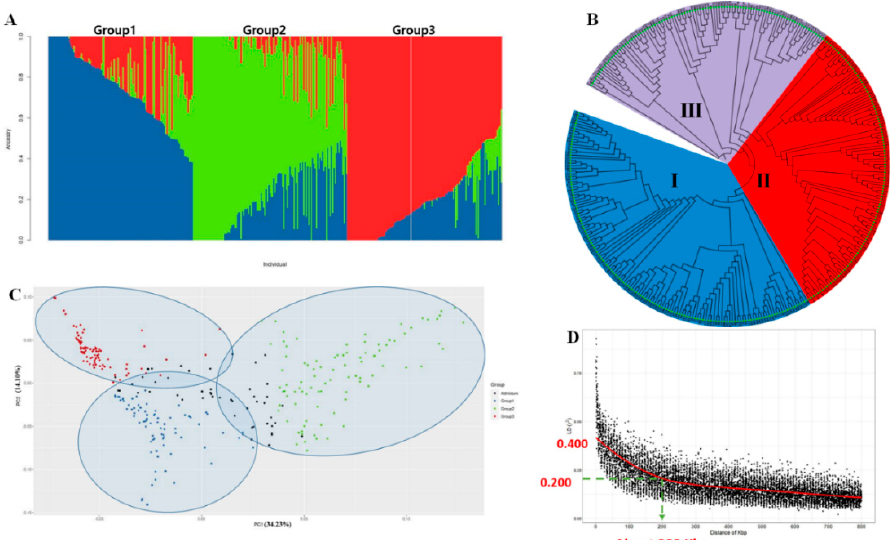
Figure 1. Population structure of 357 soybean landraces. ( A ) A bar plot diagram showing the results of clustering analysis when the number of subgroups (K) = 3. The colors blue, green, and red represent separate groups with different levels of admixture. ( B ) A phylogenetic tree of 357 soybean landraces. ( C ) Principal component plot for the 357 soybean landraces. ( D ) Genome-wide linkage disequilibrium (LD) decay for all 357 soybean landraces. R 2 indicates the squared allele frequency correlations between all pairs of SNP markers. The X -axis indicates the distance between marker